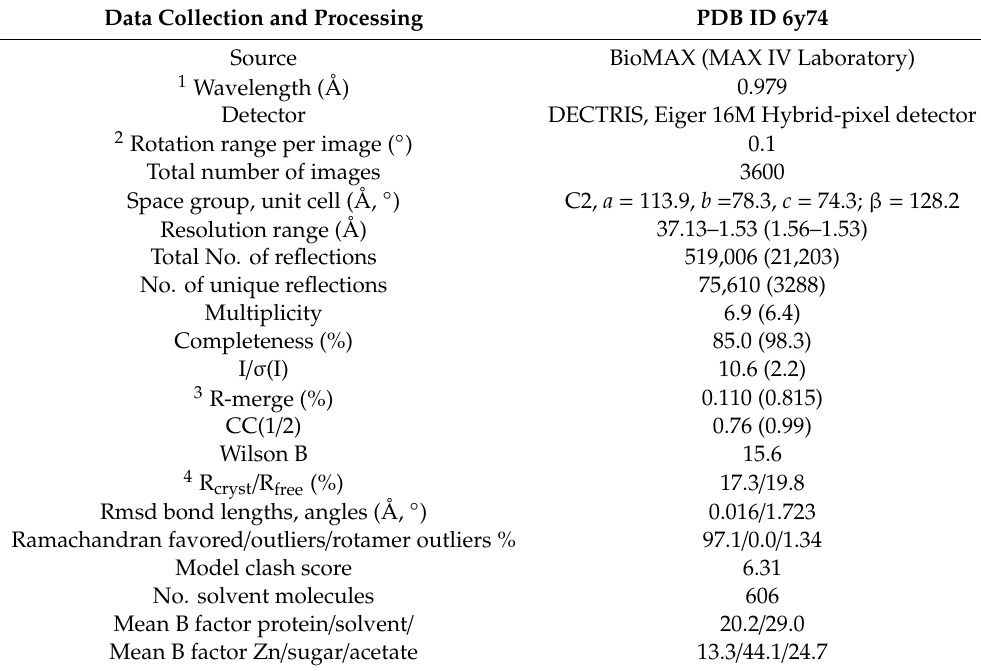
Table 1. Crystallographic data collection and refinement statistics.